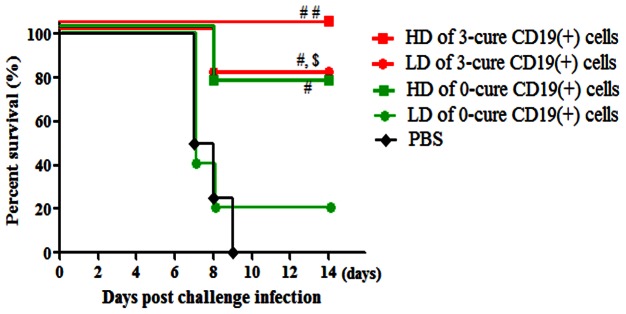
CD19(+) splenocytes of 3-cure mice provided complete resistance against ECM to B6 naïve mice.Splenocytes from each of day 7-infected 0-cure or 3-cure mice were separated into CD11c positive and negative populations. CD11c(−) cells were then sorted by anti-CD19 magnetic beads into purified CD19(+) fraction, which was adoptively transferred into naïve B6 mice by i.v. tail inoculation. Recipient mice were challenged with 104
PbA 24 hours after transfer. Curves are survival of mice that received high dose (HD) (3×107) and low dose (LD) (1.5×107) of 0-cure or 3-cure CD19(+) cells per mouse. The purity of the CD19(+) fraction was >90%. Data presented are representative of two independent experiments with four to five mice per group. Significant differences between mouse groupsare indicated using log-rank test, where #p<0.05 and ##p<0.01 versus PBS; $p<0.05 versus LD of 0-cure CD19(+) cells.